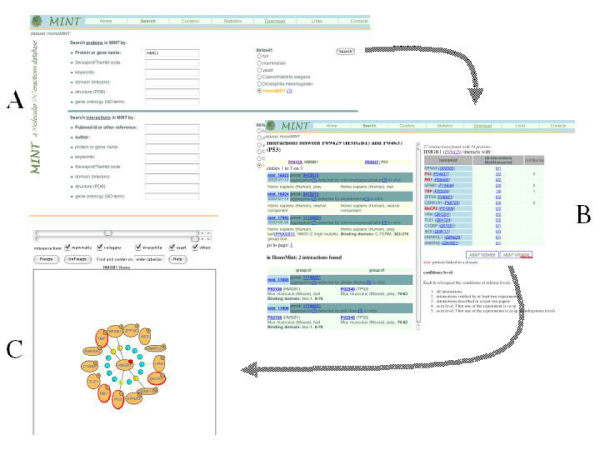
HomoMINT as a web tool. HomoMINT can be searched and analyzed by taking advantage of the tools developed for MINT. A) A search can be carried out in the protein table by entering in the form one of the following: a protein name, a Uniprot or a PDB identifier, a keyword, an InterPro domain or a gene ontology term (top part of the form). Alternatively the search can be carried out on the interaction table (centre). Finally (lower part) a BLAST search can be carried out by entering a protein sequence. B) Search output listing on the right the partners of the query protein and on the left the experimental evidence supporting the interactions. C) The Mint Viewer is an applet that permits the graphic display of interaction networks. Edges marked by small blue circles indicate that the corresponding interactions were inferred from experiments carried out in model organisms, while yellow circles mark interactions supported by direct experimental results. Interactions that are inferred from model organisms but are also supported by direct experiments are marked by yellow circles with a blue contour. A series of check boxes make it possible to visualize interactions inferred by any combination of model organism interactomes.